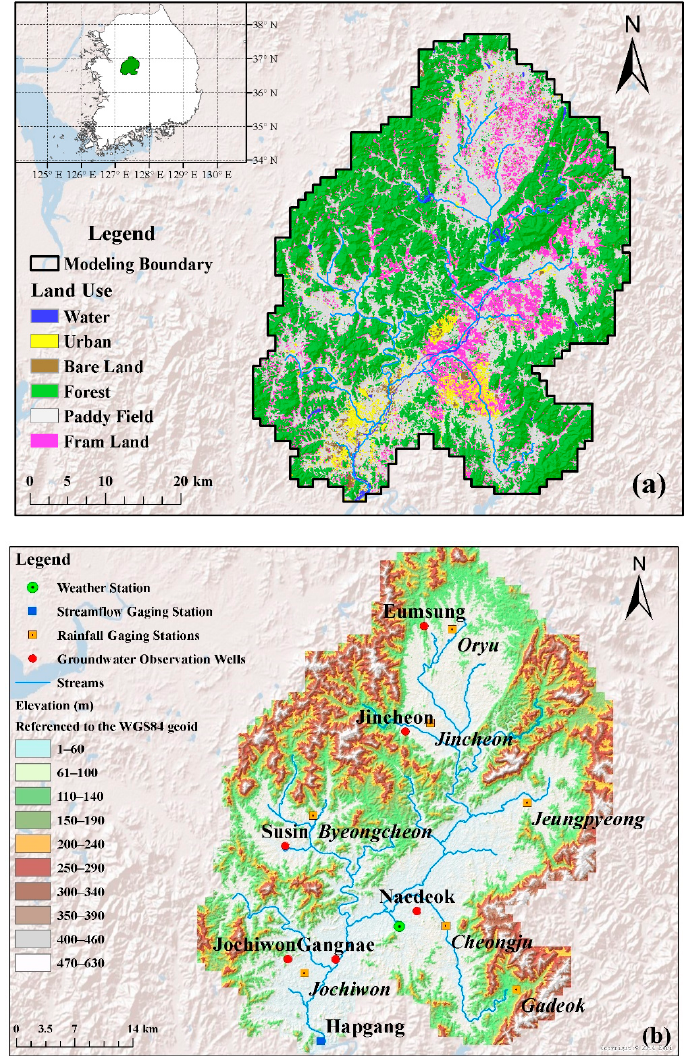
Figure 1. The study area: ( a ) Modeling domain and landuse; ( b ) topography with observation stations.